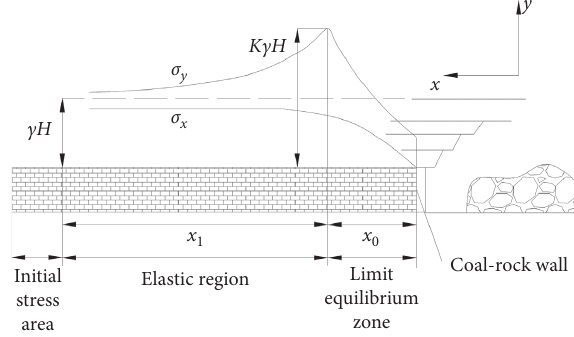
Figure 1: Area partition of abutment